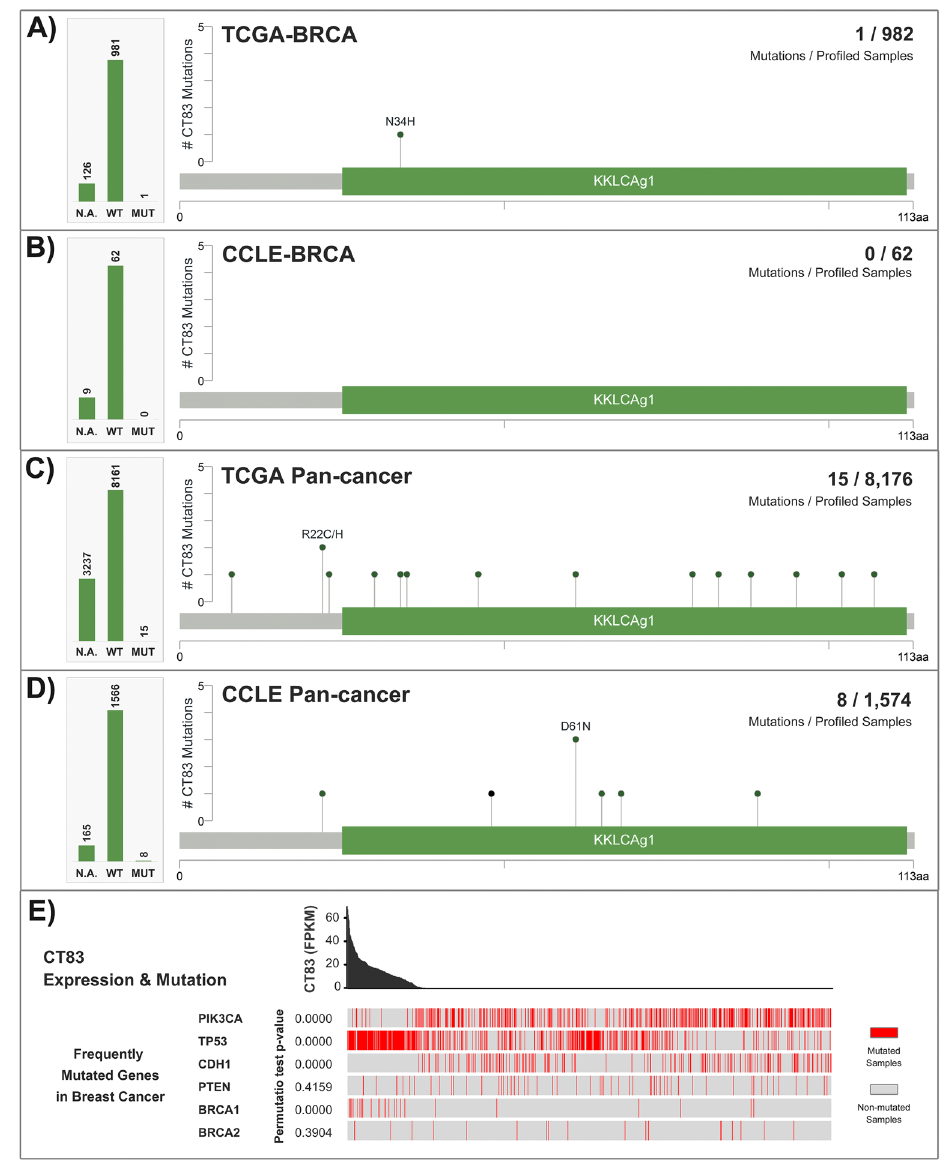
Figure 5. Mutations of CT83 in cancer. ( A ) CT83 mutations in breast cancer tissues, ( B ) breast cancer cell lines, ( C ) TCGA pan-cancer tissues, and ( D ) CCLE pan-cancer cell lines. ( E ) The correlation between CT83 mRNA expression and mutations of key genes in breast cancer based on data from the TCGA-BRCA dataset. CT83 mutation points were labeled in the corresponding regions in the linear schematic diagram of its protein. Permutation test p -values were calculated by comparing CT83 expression in key-gene-mutated samples with key-gene-unmutated samples. N.A., not available; WT, wild type; MUT,